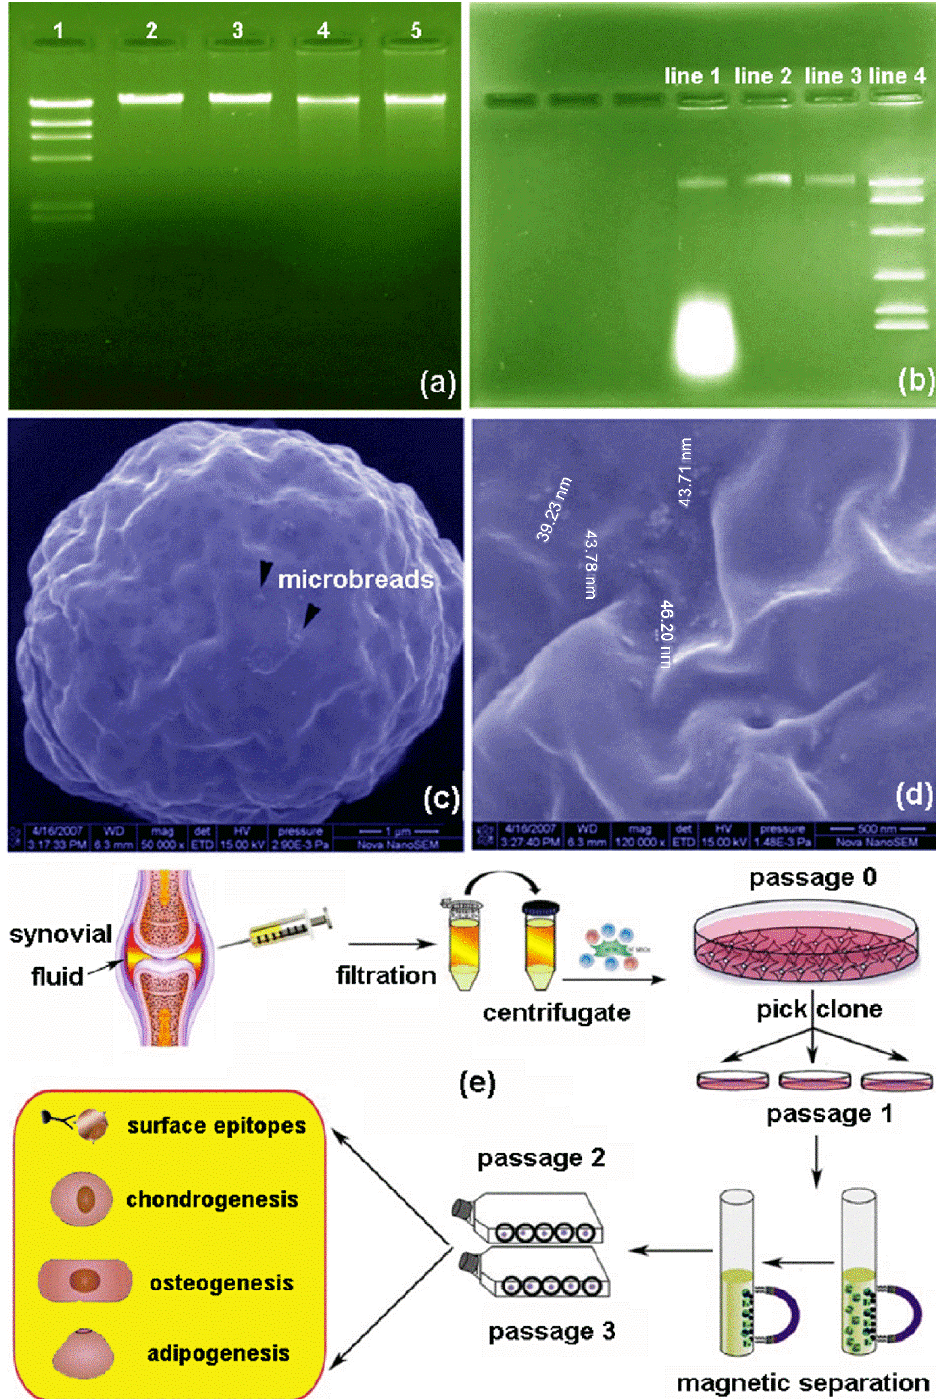
Figure 5. ( a ) The agarose gel electrophoresis of (1) a DNA molecular weight marker and the NDA obtained from (2) rat liver homogenate, (3) rat brain homogenate, (4) HCT116 and (5) human blood by magnetic nanoparticles [142]. ( b ) The agarose gel electrophoresis of (line 1) a DNA molecular weight marker and the DNA separated by (line 2) magnetic nanoparticles, (line 3) the commercial kit and (line 4) the traditional phenol – chloroform method [144]. SEM images of α6bri CD71dim cells marked by magnetic microbeads at ( c ) 50, 000× and ( d ) 120, 000× magnification, respectively [147] . ( e ) The separation of MSCs from human synovial fluid by the MACS system [149].